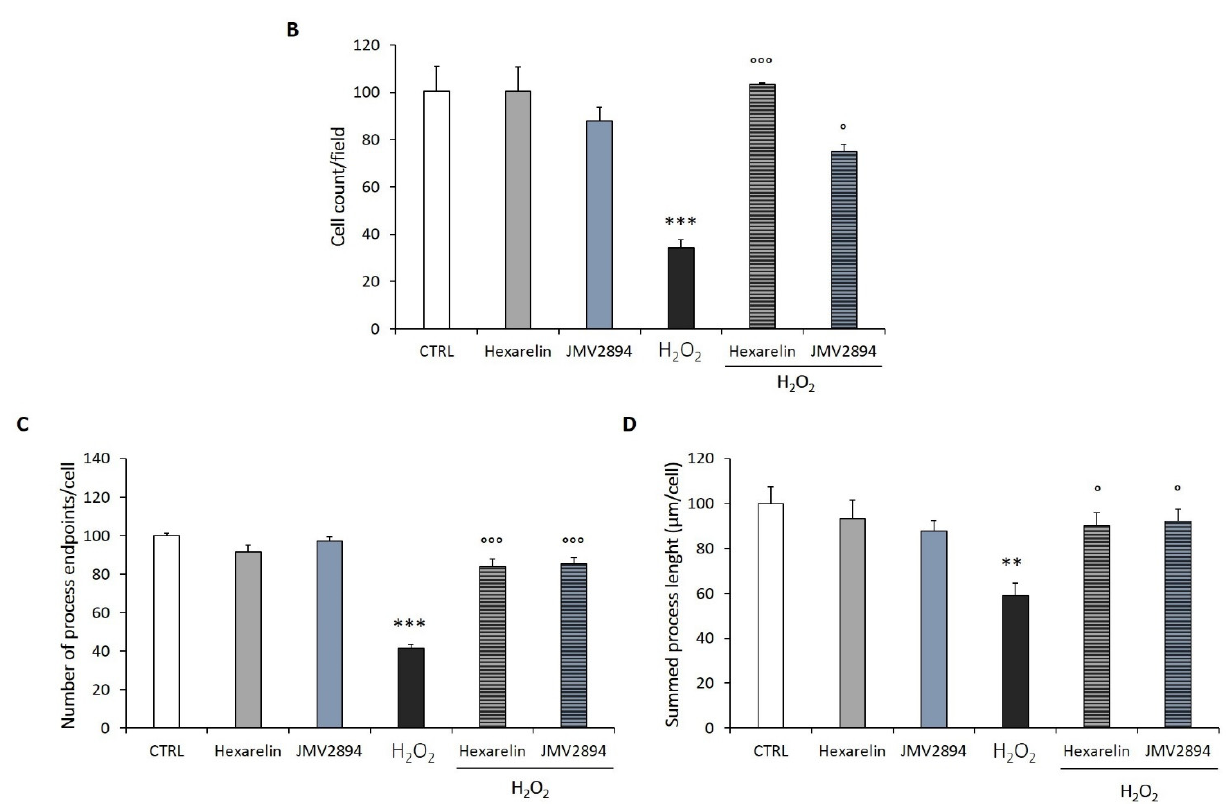
Figure 3. GHS modulated SH-SY5Y SOD1 G93A cells de-ramification induced by H 2 O 2 . ( A ) SH-SY5Y SOD1 G93A cells were seeded on poly-D-lysine pre-treated coverslips and incubated for 24 h with, or without, GHS and 150 µM H 2 O 2 . At the end of the treatment, cells were fixed and stained for phalloidin and DAPI. Images were captured with a confocal laser scan microscope. Scale bar: 20 µm. Graphical representation of the ( B ) number of cells in the same areas per each treatment; ( C ) number of process endpoints/cells; and ( D ) summed process length/cells. Data are expressed as mean ± SEM replicates obtained in 3 independent experiments (total number of cells analyzed = 100). Statistical significance: ** p < 0.01, and *** p < 0.001 vs. CTRL; ° p < 0.05, and °°° p < 0.001 vs.